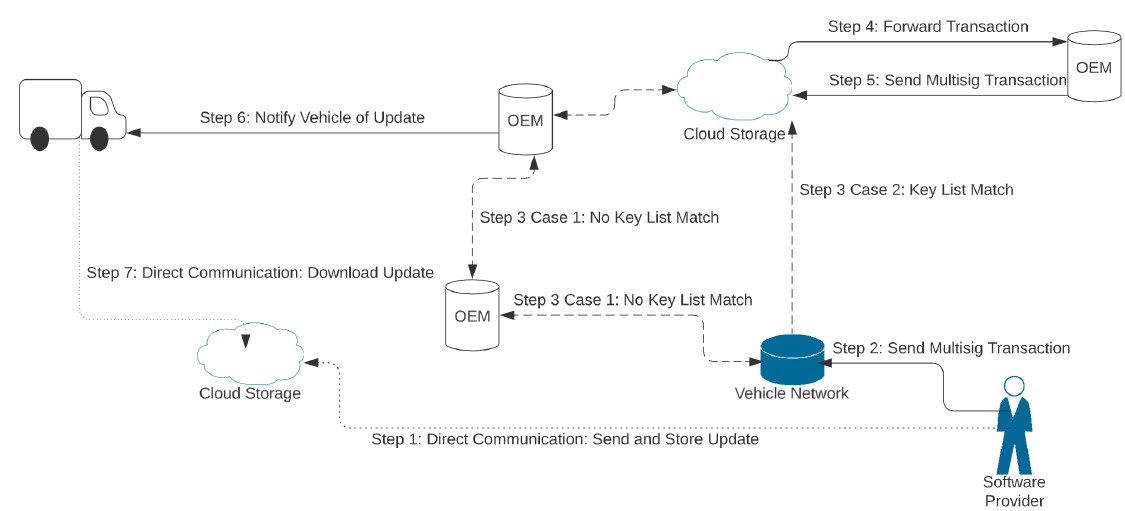
Figure 8. A diagram showing how software updates are created, verified, and delivered to CAVs across the network through a cloud-based system, inspired by